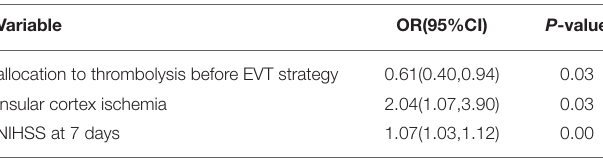
TABLE 3 | Multivariable binary logistic regression analysis of variables associated with anxiety/depression in EQ-5D-5L at 90 days ( n =